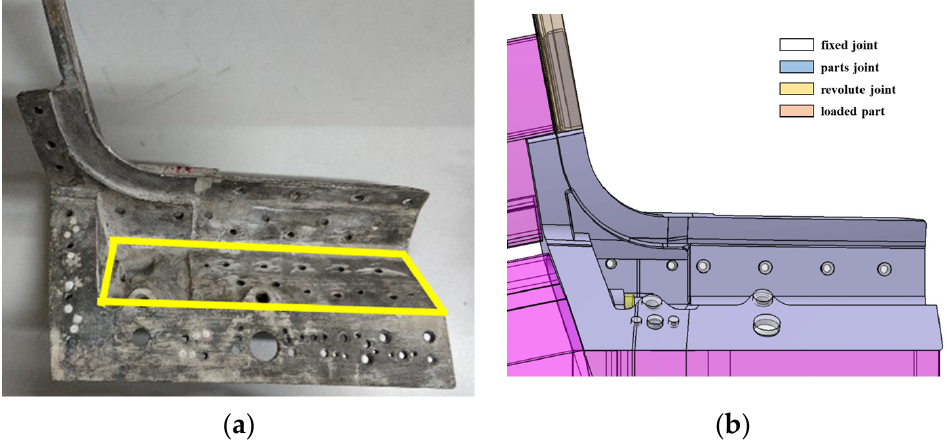
Figure 1. Connections on the fuselage. ( a ) Main loading area, ( b ) Connection of the support.